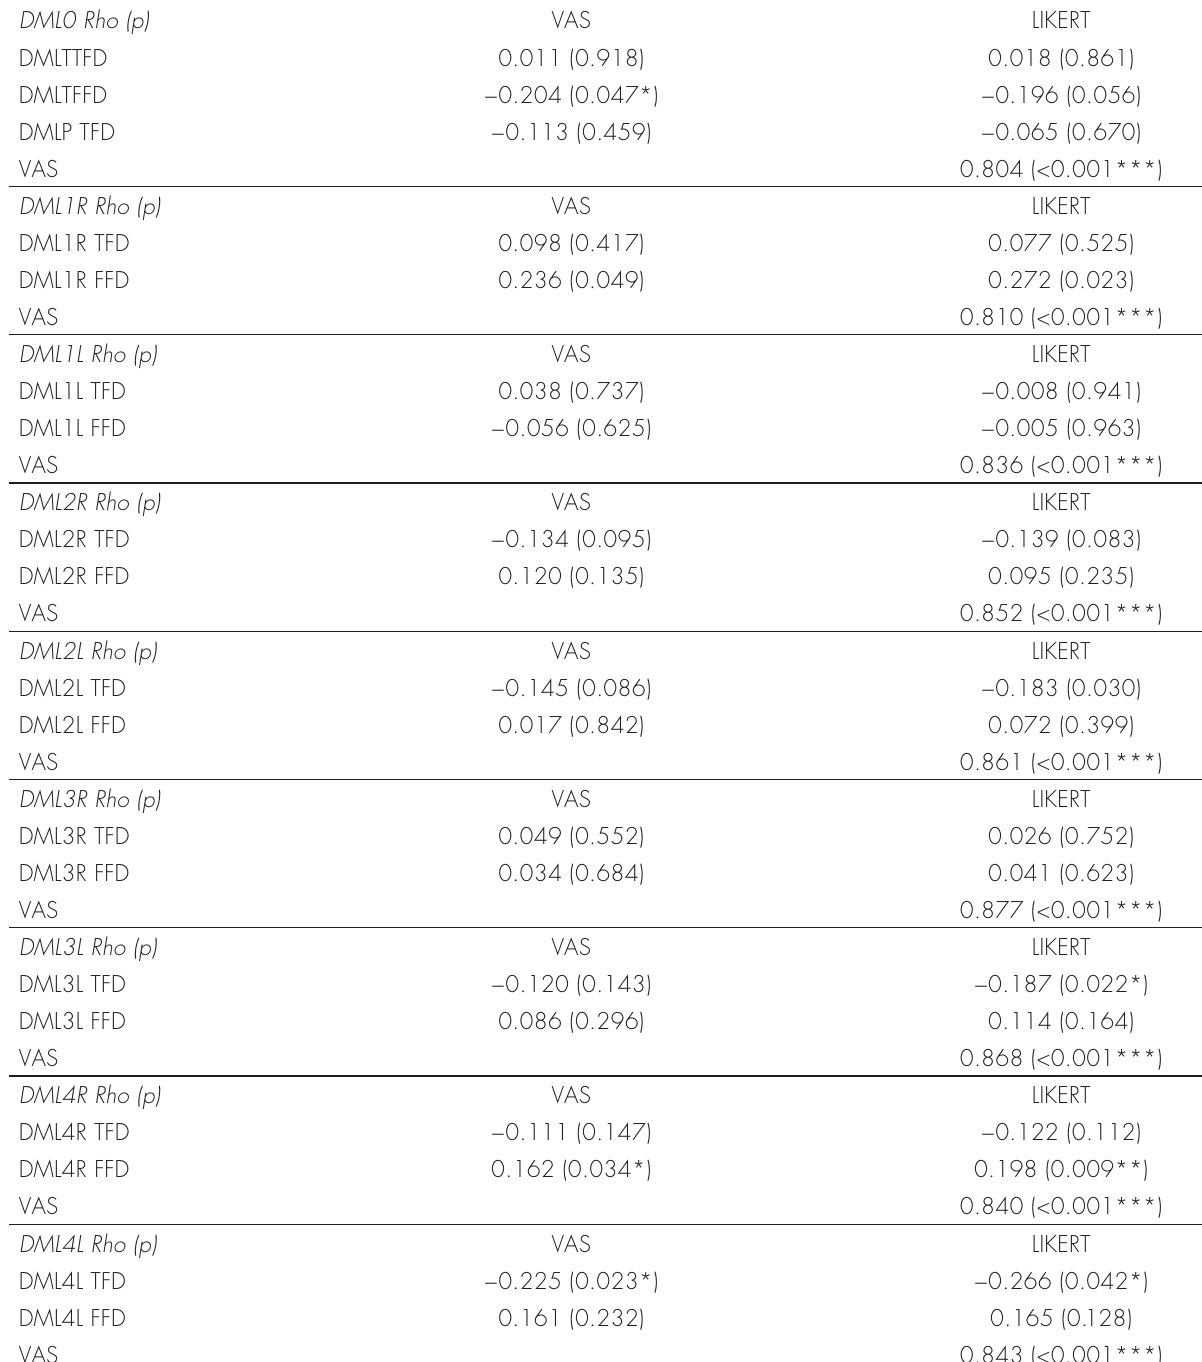
Table III. The correlation between datasets of eye-tracking, VAS, and Likert